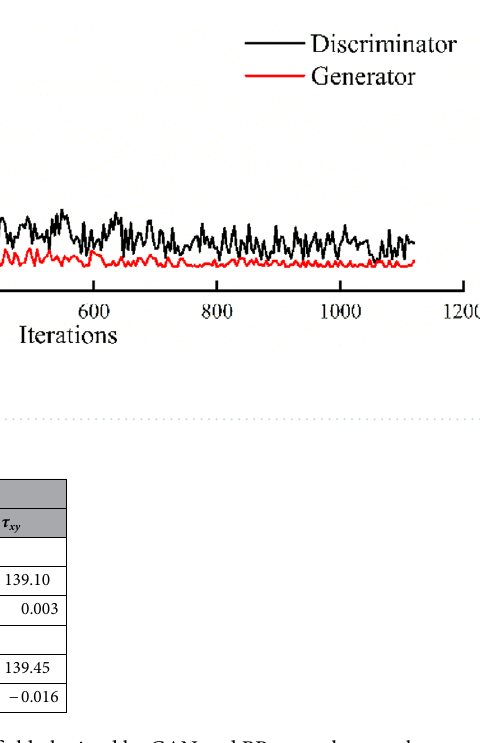
Table 6. Regression factors in ancient stress field obtained by GAN and BP neutral